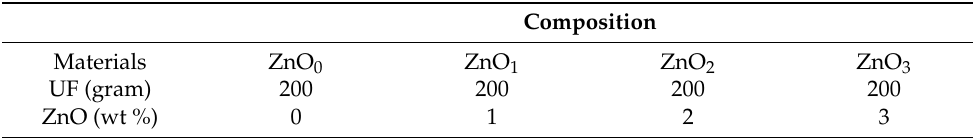
Table 1. Urea formaldehyde and zinc oxide (UF-ZnO) nanofiller compositions.